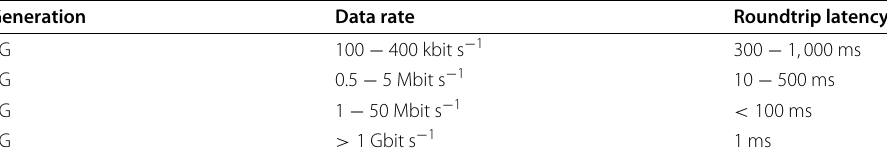
Table 3 Average data rate and roundtrip latency of wireless communication standards (Gavriluta et al.